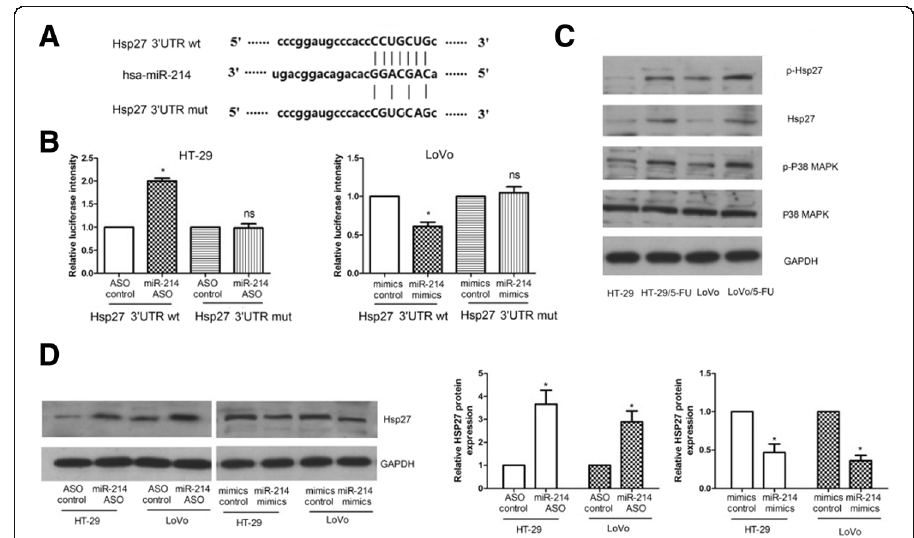
Fig. 3 miR-214 targets Hsp27 by binding to the 3 ’ UTR. a – The complementary site of miR-214 in the 3 ’ UTR of Hsp27 as predicated using bioinformatic analysis. b – Hsp27 3 ’ UTR wtand Hsp27 3 ’ UTR mutant luciferase constructs were simultaneously transfected into cells with miR-214 ASO, miR-214 mimics or corresponding controls. Luciferase activities were measured at 48 h post-transfection. c – Western blots were done to detect the protein levels of Hsp27, p-Hsp27, p-P38 MAPK and P38 MAPK in the cells. GAPDH was used as the internal control protein. d – Hsp27 protein levels in miR-214 ASO or miR-214 mimics transfected into HT-29 and LoVo cells were measured viawestern blot. Data represent the means ± SEM from three independentexperiments. * p < 0.05